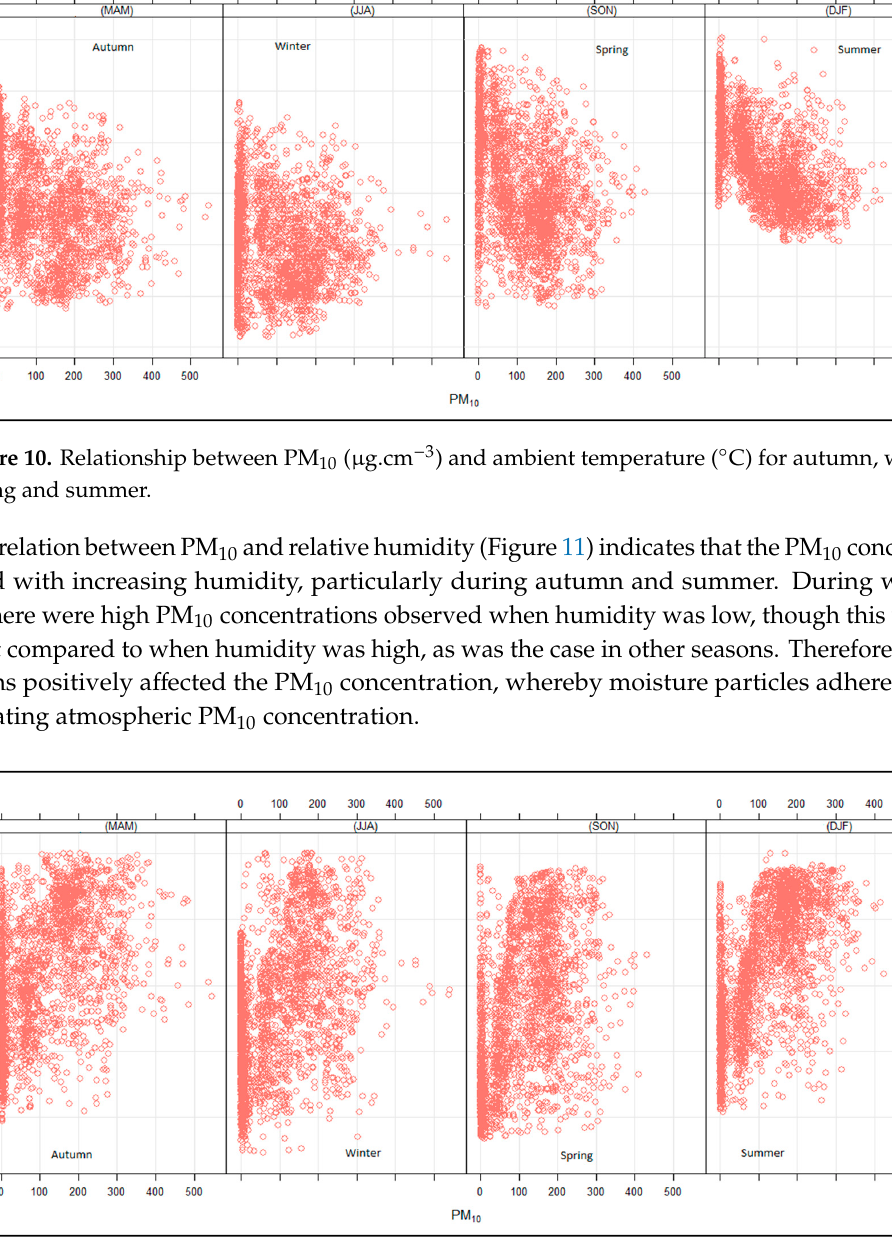
Figure 11. Relationship between PM 10 (µg.cm − 3 ) and relative humidity (%) for autumn, winter, spring and summer.